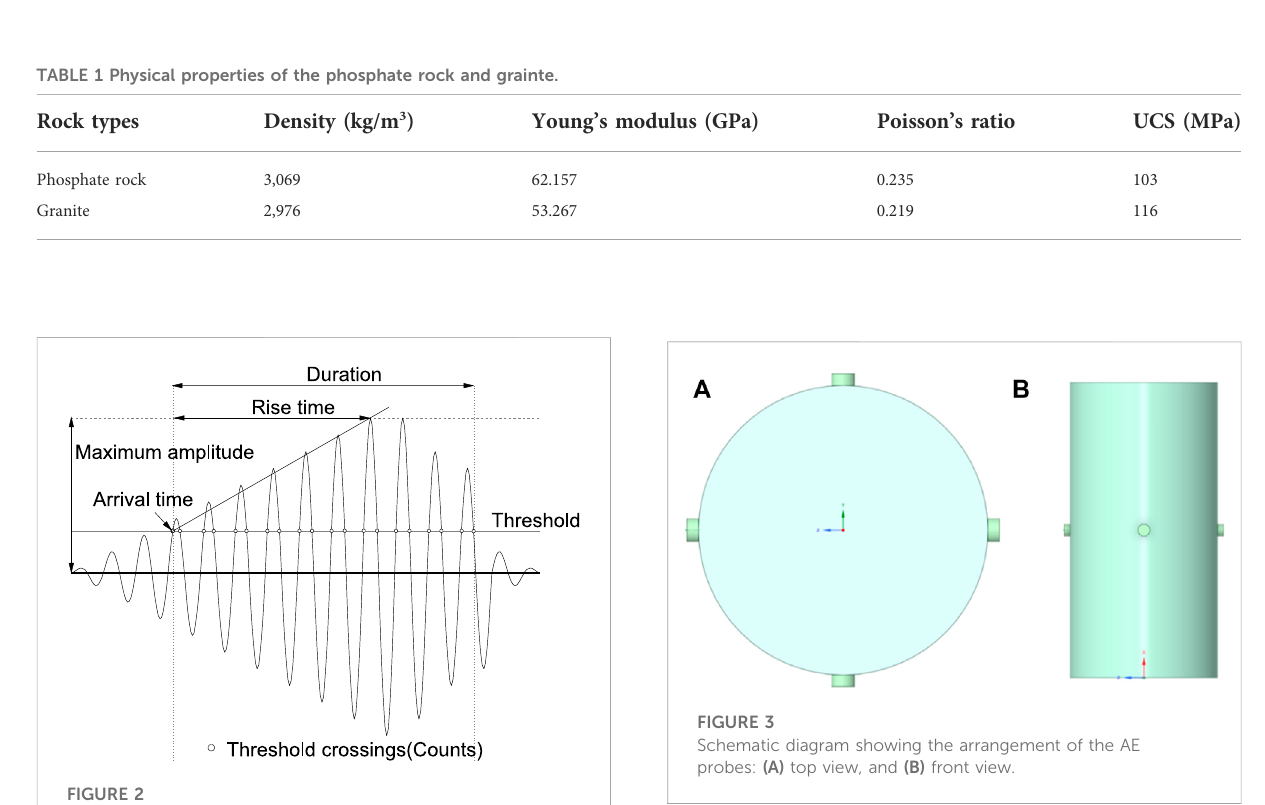
FIGURE 2 Parameters used to interpret the AE data.